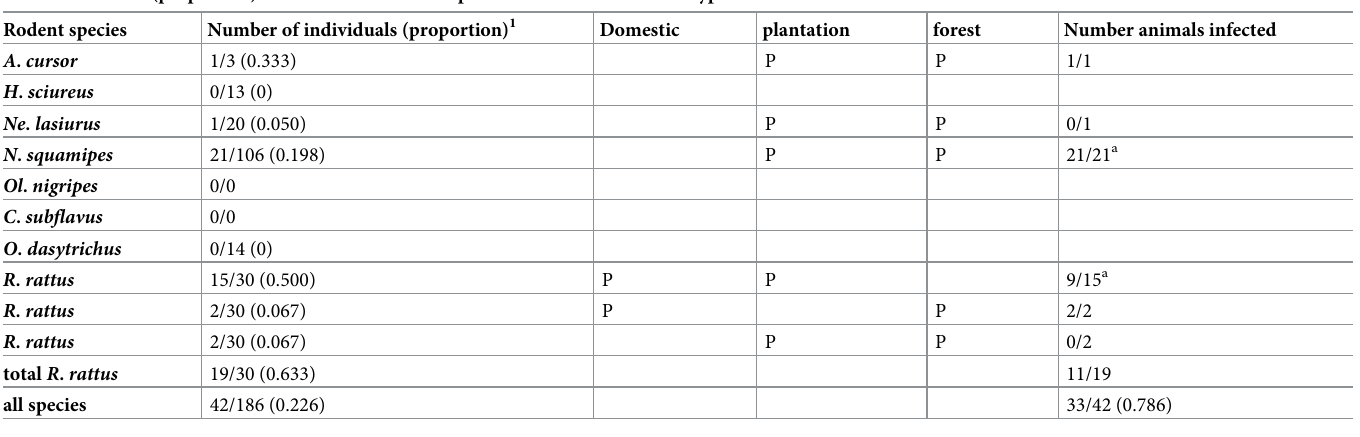
Table 6. Number (proportion) of individual rodents captured in more than one ecotype. Rodent species